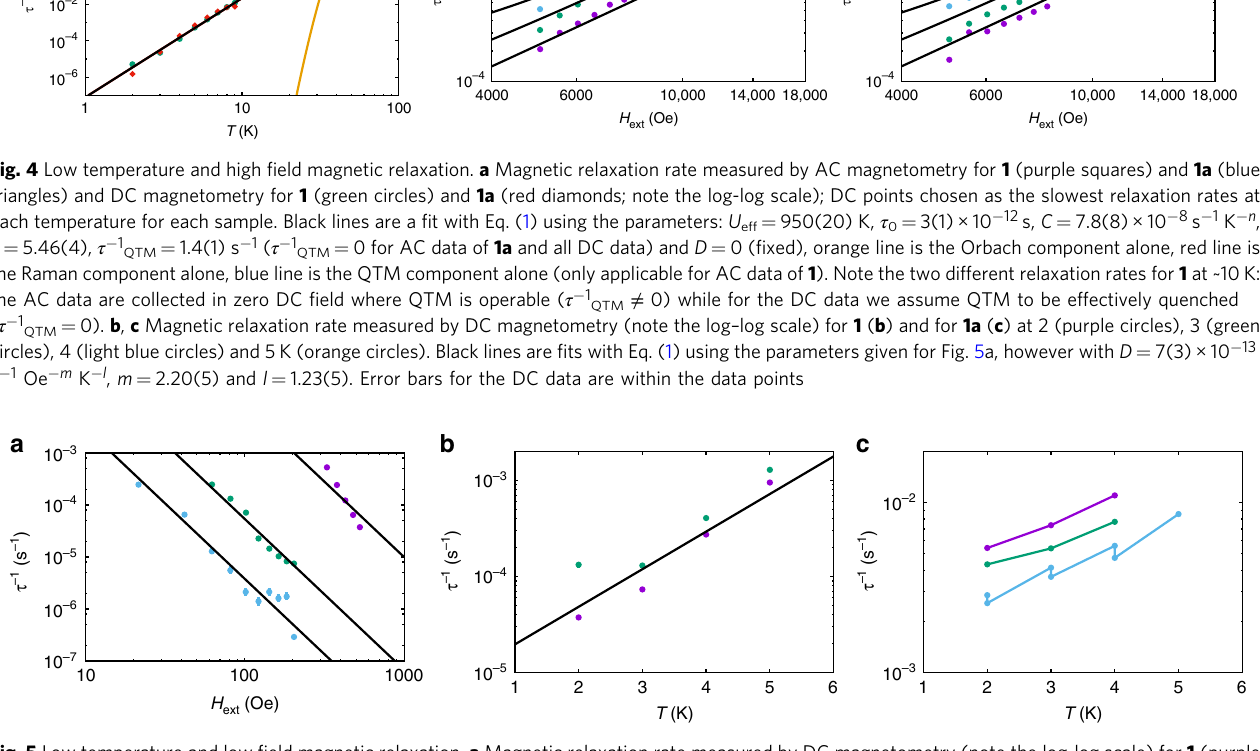
Fig. 4a for both 1 and 1a simultaneously ( U eff , τ 0 and τ − 1 QTM are fi xed from above), assuming that QTM is effectively quenched under the relevant fi elds (i.e., τ − 1 QTM = 0 for the DC data), we obtain C = 7.8(8) × 10 − 8 s − 1 K − n and n = 5.46(4) (Fig. 4a). [We